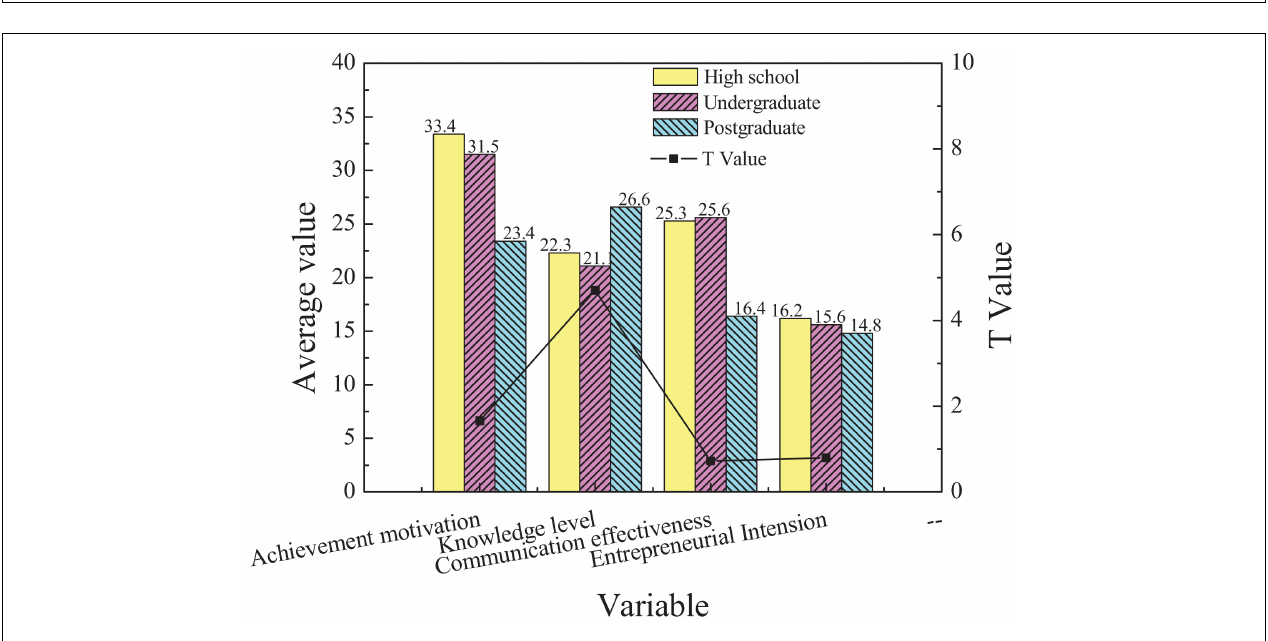
FIGURE 3 | Comparison of scores of new entrepreneurs of different genders in different EI dimensions.